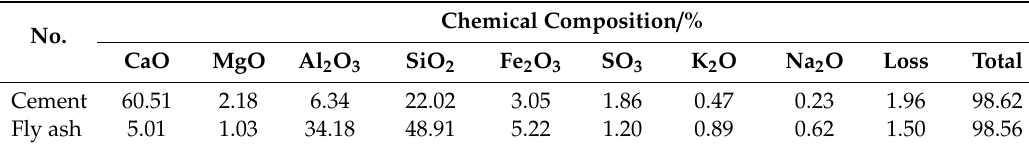
Table 1. Chemical composition of cement and fly ash.